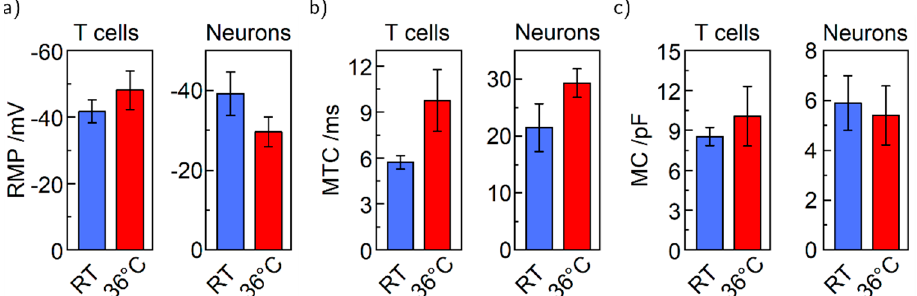
Figure 4. Basic electrophysiological properties of T cells and neurons at RT and 36 °C, respectively. ( a ) Resting membrane potential. ( b ) Membrane time constant. ( c ) Membrane capacitance. T cells: n (RT) = 11, n(36 °C) = 7. Neurons: n (RT) = 8, n (36 °C) = 7.